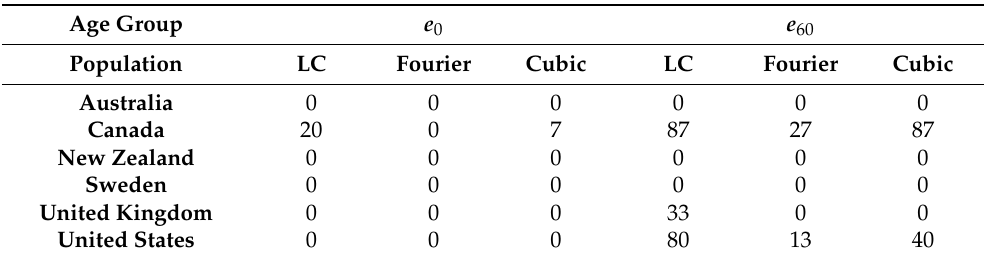
Table 4. Proportions (%) of observed life expectancies at ages 0 and 60 falling outside 95% prediction intervals, predicted over the last 15 years of the sample. The mortality index is modelled by a piecewise RWD with one